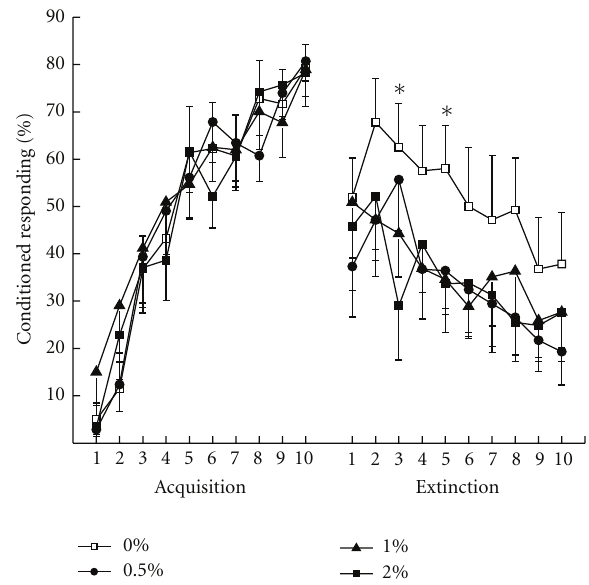
Figure 3: Mean percent conditioned responding during 10 days of Acquisition and 10 days of tone-alone Extinction separated by 8 weeks on a diet of 0%, .5%, 1%, or 2% cholesterol added to normal rabbit chow. ∗ P < .